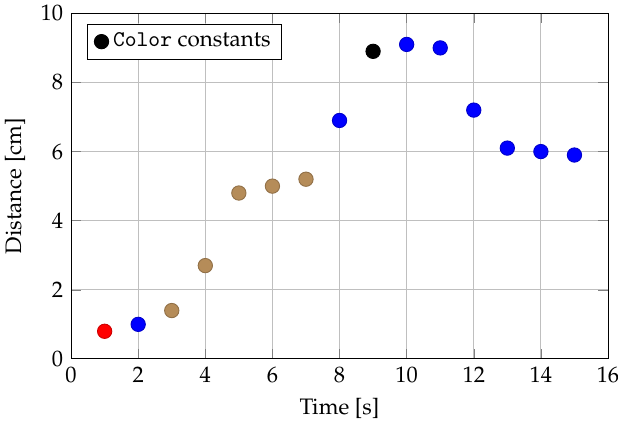
Figure 8. Color reconstruction over time at different distances for two objects: a brown object is replaced at the 8th second by a blue